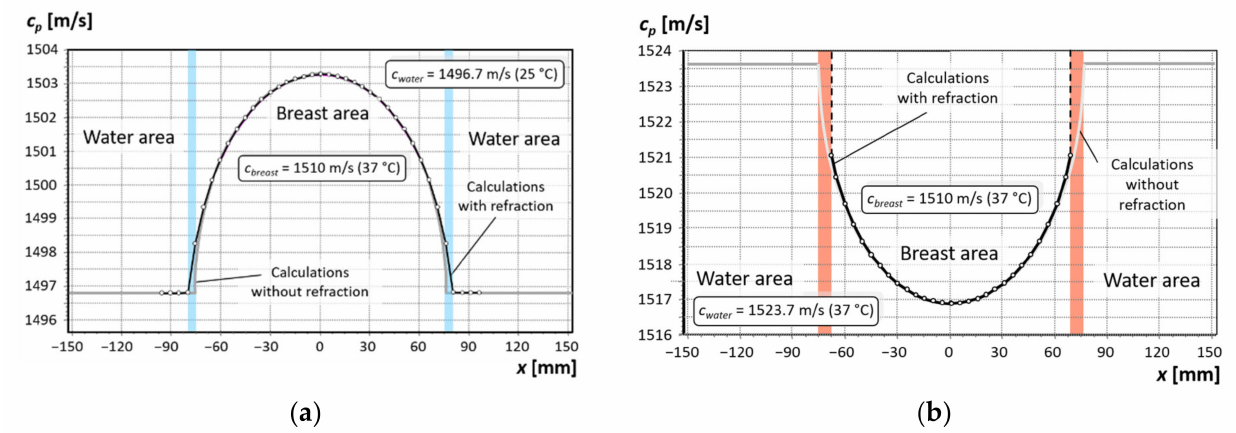
Figure 3. Calculated values of ultrasound velocity projection through a circular cross-section of a cylinder without and with refraction for refraction indices: ( a ) n = 0.991; ( b ) n = 1.009. The ultrasound velocity projection value c p is determined as the ratio of the rectilinear path of the wave passage between the transmitter and receiver to the measured (simulated) transit